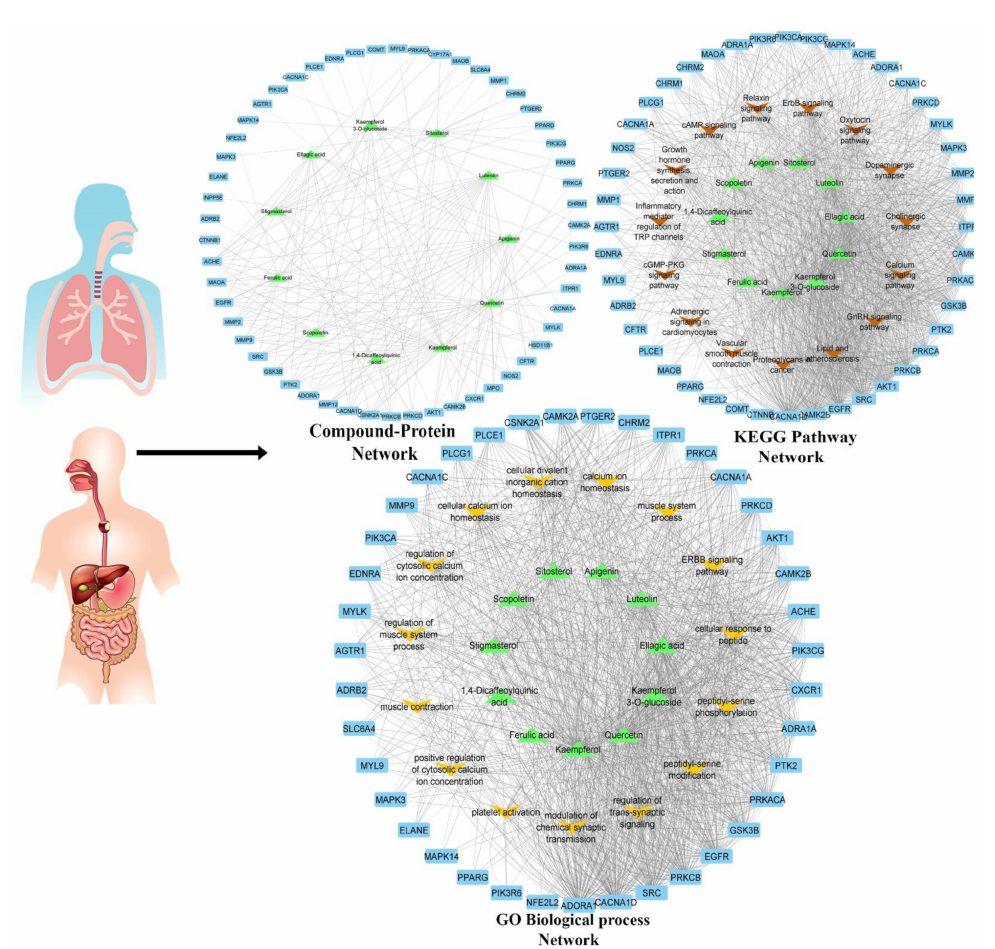
Figure 4. Network interaction analysis of bioactive compounds of C. sativus seeds with target disease proteins (C-T-D), compound target pathway (C-T-P) network interaction KEGG and GO biological process